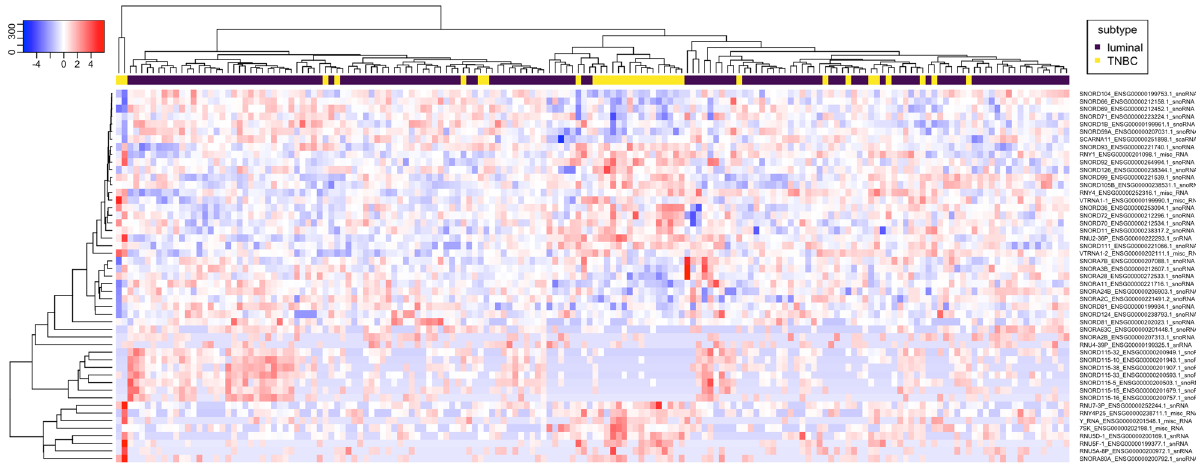
Figure 3. Forty-nine sncRNAs were found as characteristic ( Padj < 0.01) to TNBC or luminal BC. The hierarchical clustering of 33 TNBC and 133 luminal BC samples (invasive local disease) (columns) and differentially expressed sncRNAs (rows) using Pearson metrics. Log2 fold change is marked by the color scale (from blue to red).